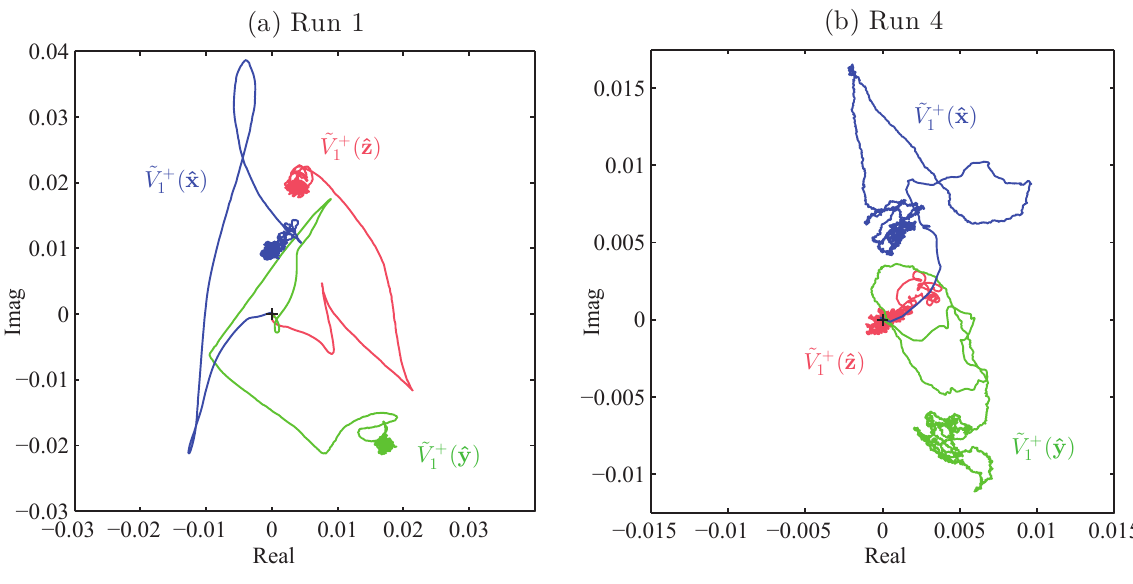
Figure 13. Phase portraits of ˜ V + (ˆ k , t ), ˆ k = ˆ x , ˆ y and ˆ z , for (a) Run 1 and (b) Run 4. These are the only ˜ V + ( k , t ) variables exhibiting coherent structure. (The variables are normalized by N 3 / 2 , N = 128.) Here, ˜ V + ( ˆ k , t ) = ˜ u + ( ˆ k , t ) , except in ( b ), where ˜ V + ( ˆ z , t ) [ 0.97 ˜ u + ( ˆ z , t ) + 0.23˜ b + ( ˆ z , t )].